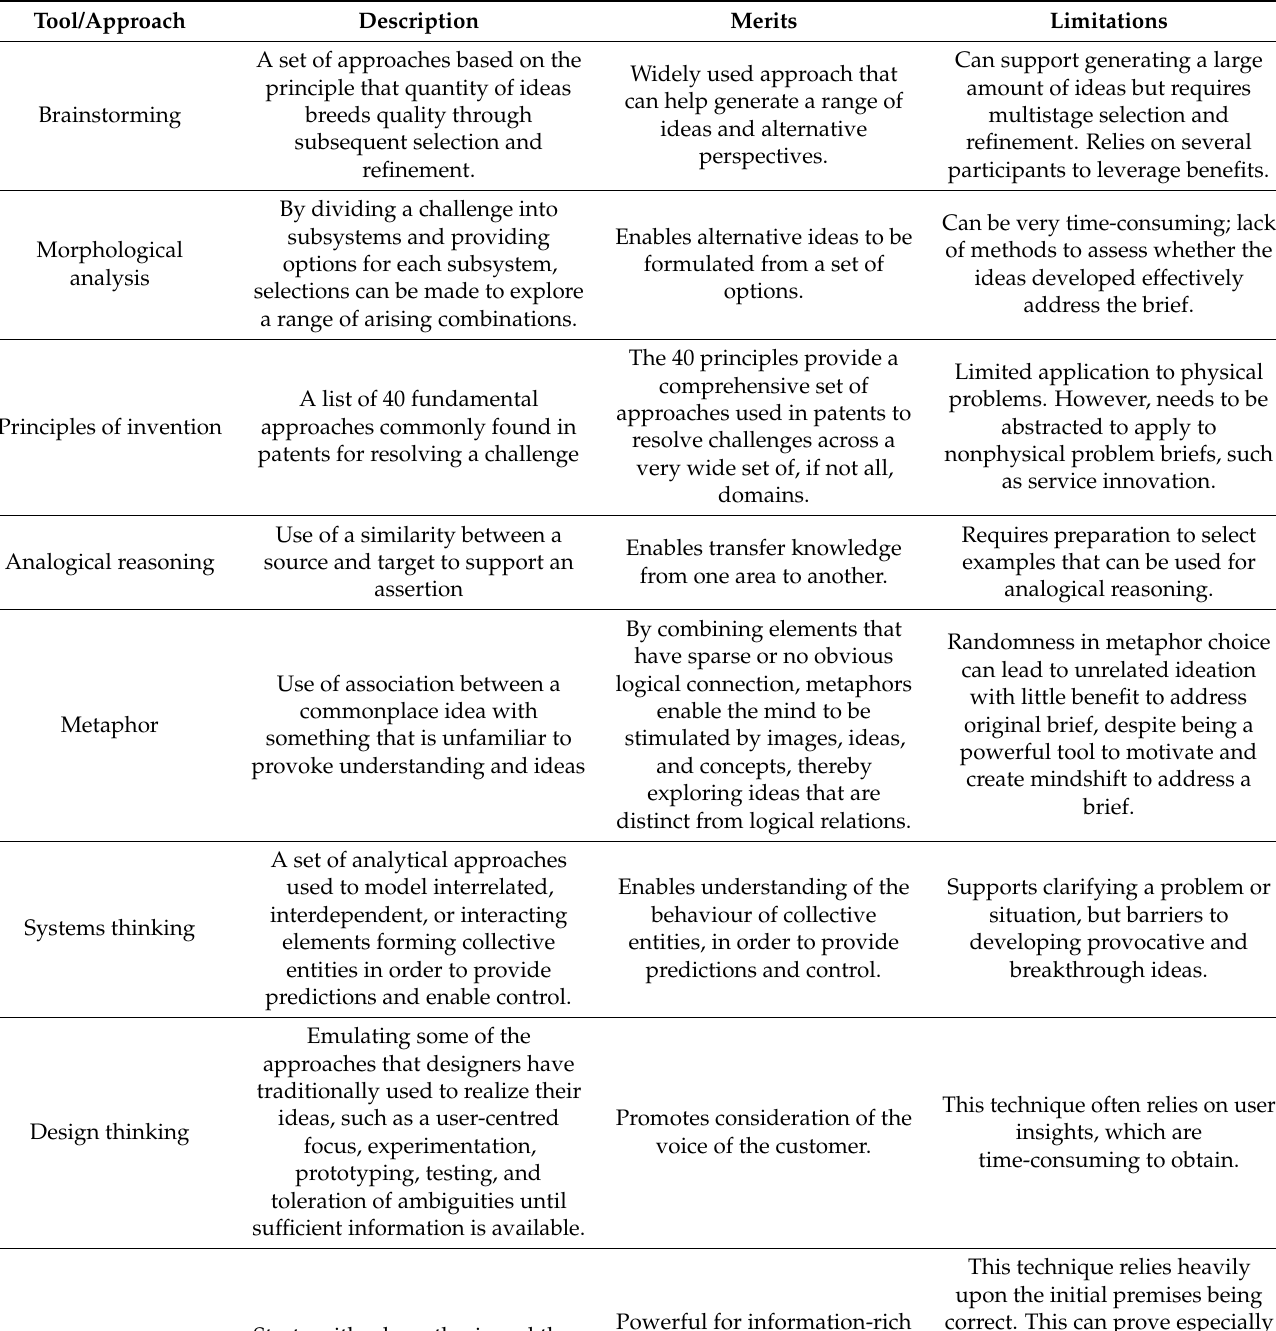
Table 1. Short description and merits/limitations of various creativity tools and approaches to